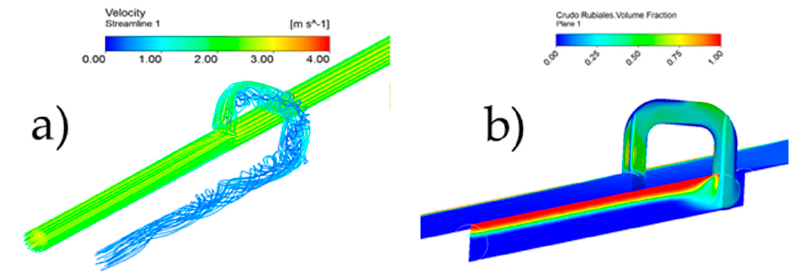
Figure 3. Multiphase CFD simulation in a pipeline loop, ( a ) Velocities streamlines, ( b ) Oil fraction [2].